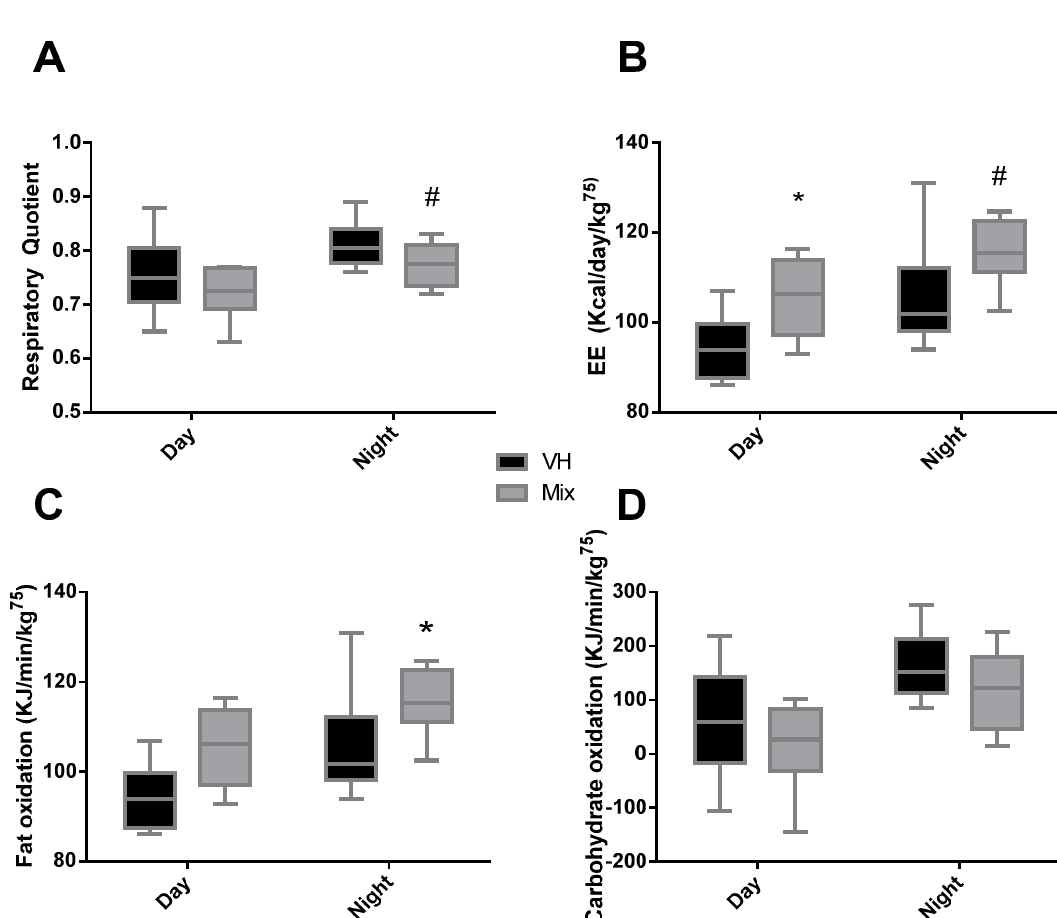
Figure 2. Respiratory quotient (RQ) ( A ), energy expenditure (EE) ( B ), fat oxidation ( C ), and carbohydrate oxidation ( D ) during day and night, measured during 24 h four or five days before sacrifice, of Wistar rats fed a CAF diet for 11 weeks and supplemented with the vehicle or a mix of ingredients containing GSPE, anthocyanins from bilberry and blackcurrant, CLA, and CFH during the last three weeks. Box plots represent the median and Tukey whiskers ( n = 8), and both groups were compared with Student’s t -test (* p < 0.05, # p < 0.1).